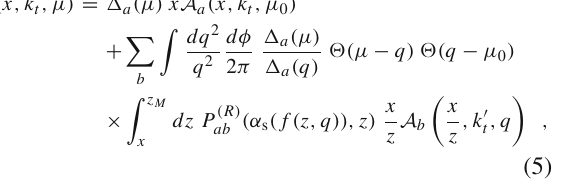
Fig. 2 The reduced cross section ˜ σ( k t )/ ˜ σ( 0 ) as a function of the transverse momentum k t , 2 of the incoming gluon at for different values of k t , 1 and x 1 , (right) for different heavy flavor masses and fixed values of k t , 1 and x 1